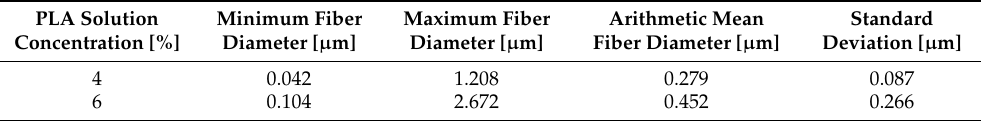
Table 2. Parameters of PLA fibers. PLA Solution